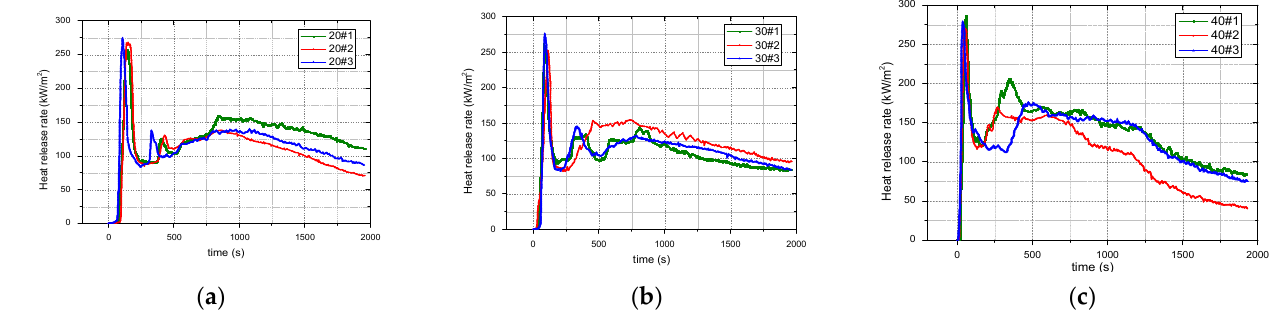
Figure 5. HRR curves of XLPE cables under different radiation intensities. ( a ) 20 kW/m 2 , ( b ) 30 kW/m 2 , ( c ) 40 kW/m 2 .